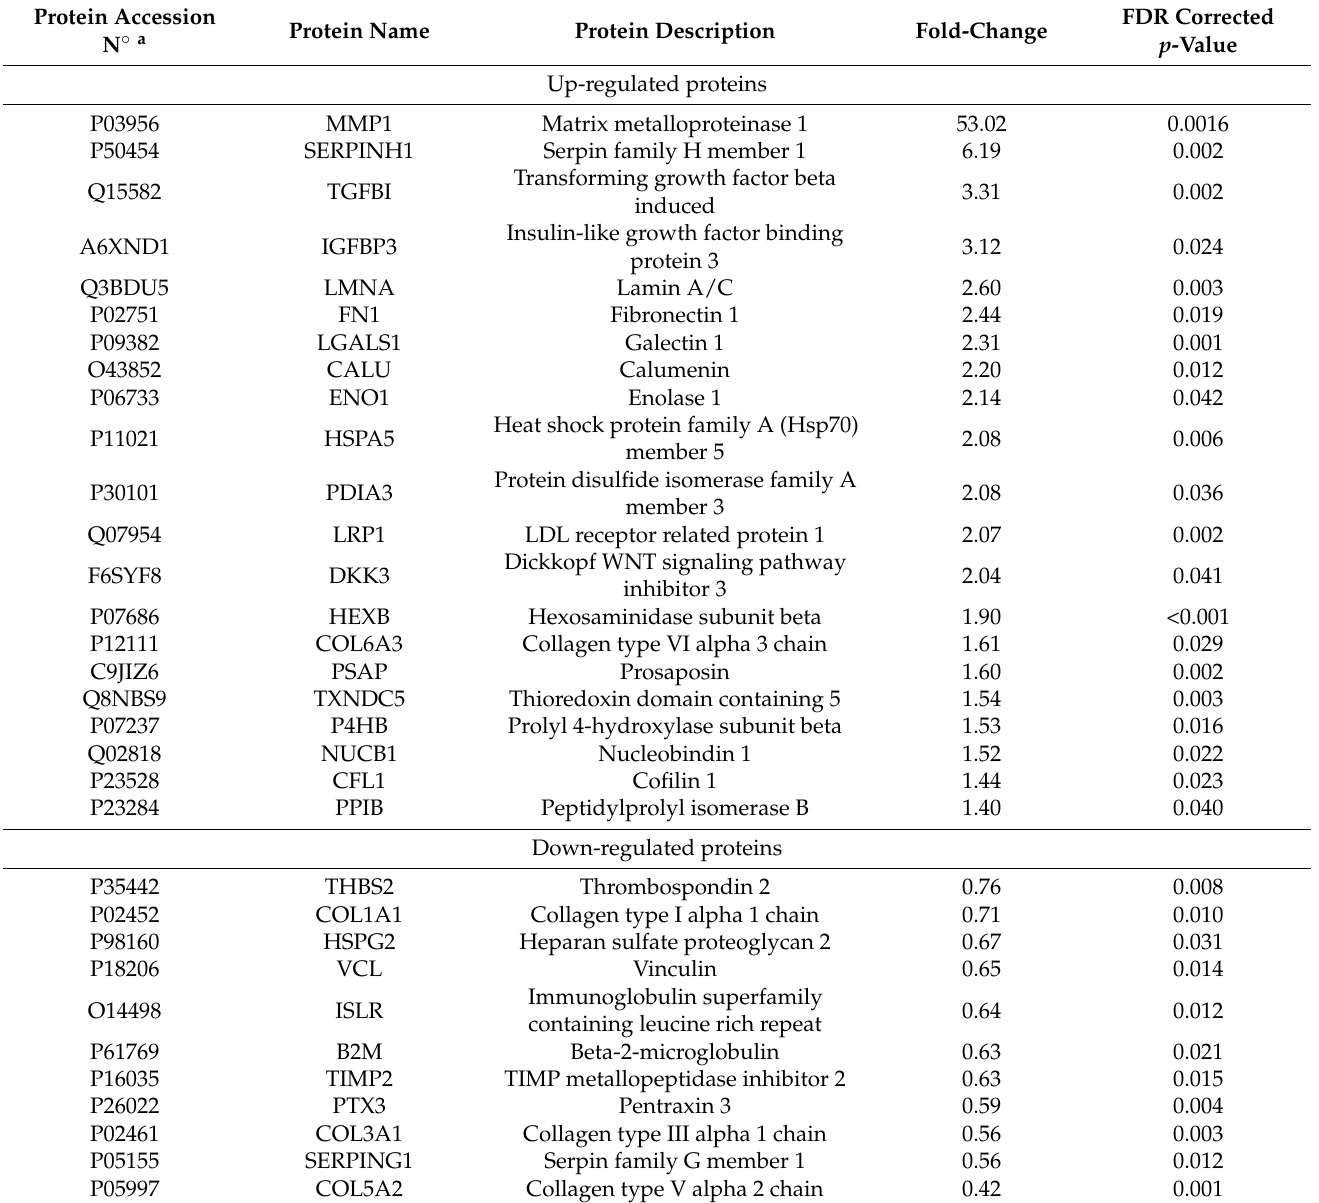
Table 1. Proteins identified by LC-MS/MS analysis in the secretome of hEDS myofibroblasts. Protein Accession N ◦